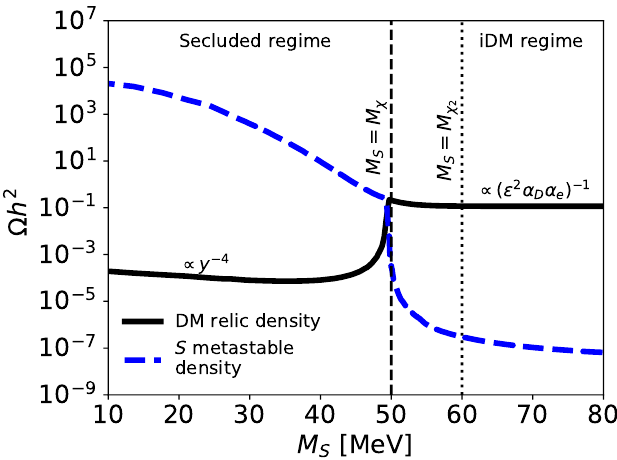
Figure 3. Dark matter relic density (cid:10) h 2 and dark Higgs boson metastable abundance (cid:10) h 2 malized to the relic density it would have had today if it had been stable) as function of the dark Higgs boson mass. We have chosen M (cid:31) = 50 MeV, M (cid:31) that the correct relic density is obtained in the iDM regime when M S > M (cid:31)